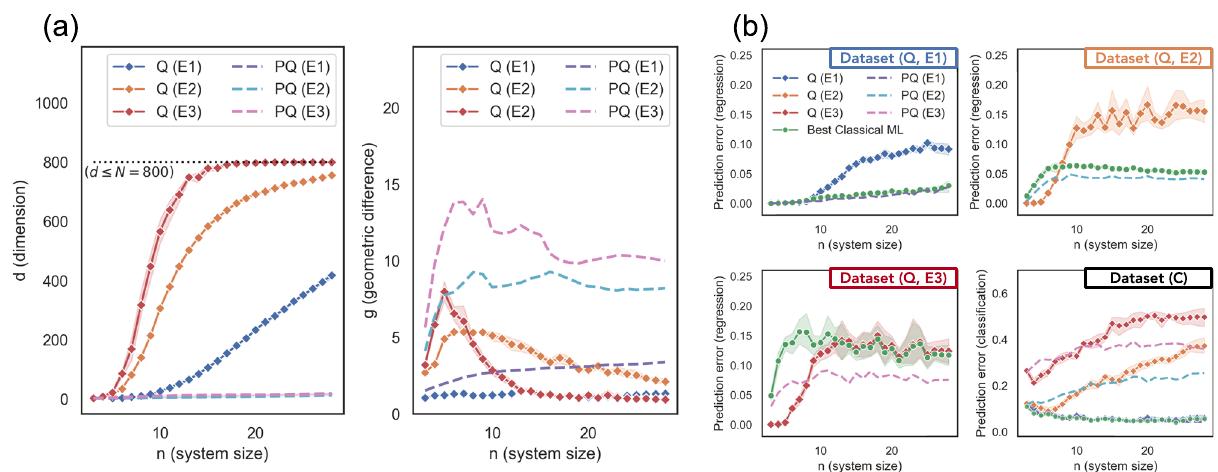
Fig. 3 Relation between dimension d , geometric difference g , and prediction performance. The shaded regions are the standard deviation over 10 independent runs and n is the number of qubits in the quantum encoding and dimension of the input for the classical encoding. a The approximate dimension d and the geometric difference g with classical ML models for quantum kernel (Q) and projected quantum kernel (PQ) under different embeddings and system sizes n . b Prediction error (lower is better) of the quantum kernel method (Q), projected quantum kernel method (PQ), and classical ML models on classical (C) and quantum (Q) datasets with number of data N = 600. As d grows too large, the geometric difference g for quantum kernel becomes small. We see that small geometric difference g always results in classical ML being competitive or outperforming the quantum ML model. When g is large, there is a potential for improvement over classical ML. For example, projected quantum kernel improves upon the best classical ML in Dataset (Q, E3).